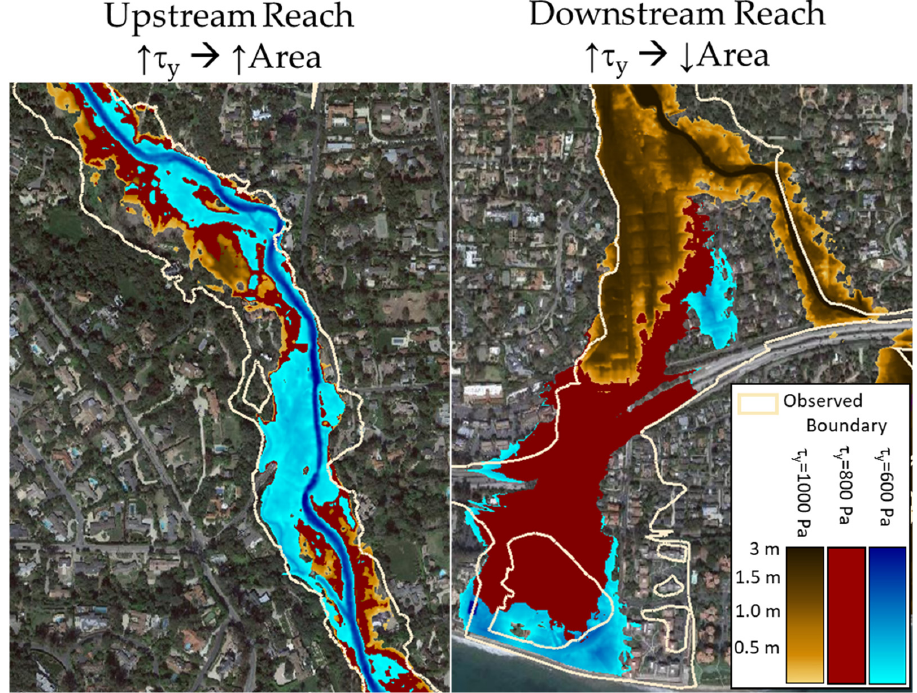
Figure 13. Illustration of the yield strength–area tradeoff. Higher yield strengths inundated more of the upstream reaches but less of the downstream area, while lower yield strengths spread out to inundate more of the flatter, downstream, area but did not inundate as much of the higher gradient, upstream, reach.